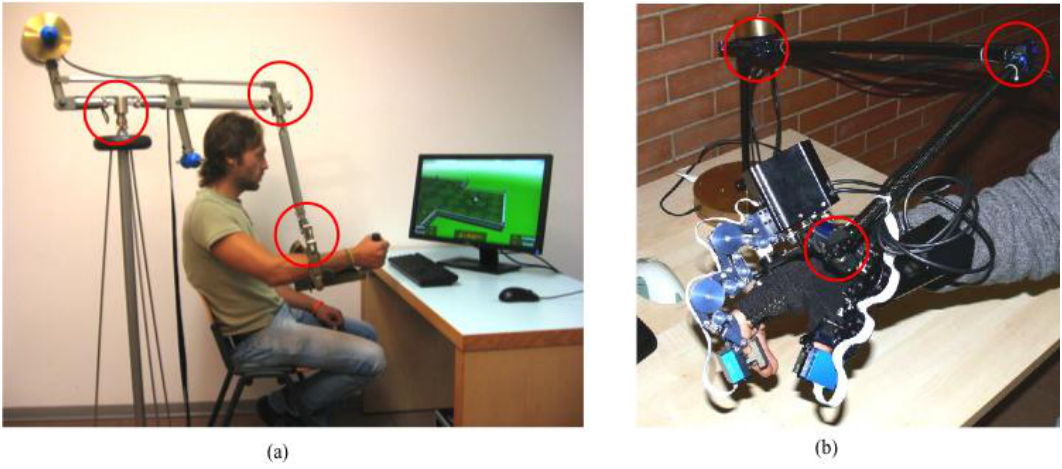
Figure 10. ( a ) Track-Hold: mechanical tracker employed for VR rehabilitation application and ( b ) HFF-Tracker: mechanical tracker employed for tracking portable haptic interfaces.